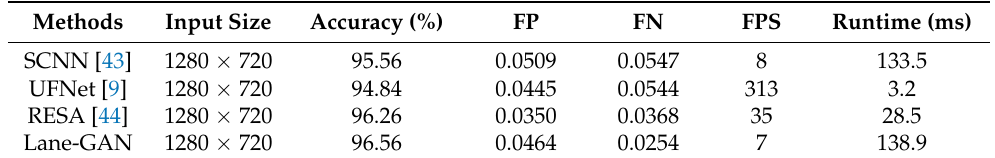
Table 2. The proposed method is compared with retrained state-of-the-art methods on the constructed dataset.